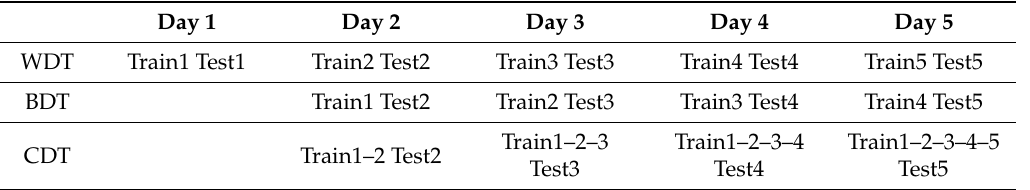
Figure 2. Shows the interface of GUI during the testing phase. The blue dot at the center of the XY plane corresponds to the rest position whereas red rectangles represent the target. Subjects had to achieve targets with the cursor placed at the origin in the XY plane. The target appeared randomly on any of the XX’ or YY’ axes. Each target was represented by a movement shown in Figure 1c. Table 1. Complete scheme of the experiment. Three real-time tests were done on Days 2–5 and one on Day 1 .